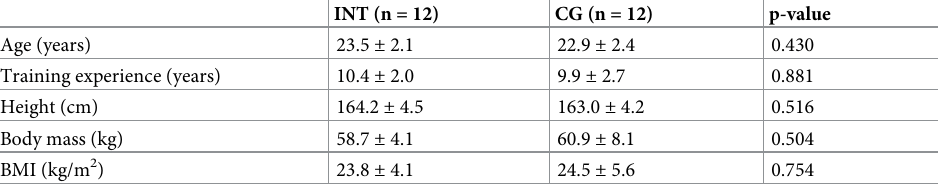
Table 1. Participant demographic characteristics in the INT group (INT) and the control group (CG) (mean ±